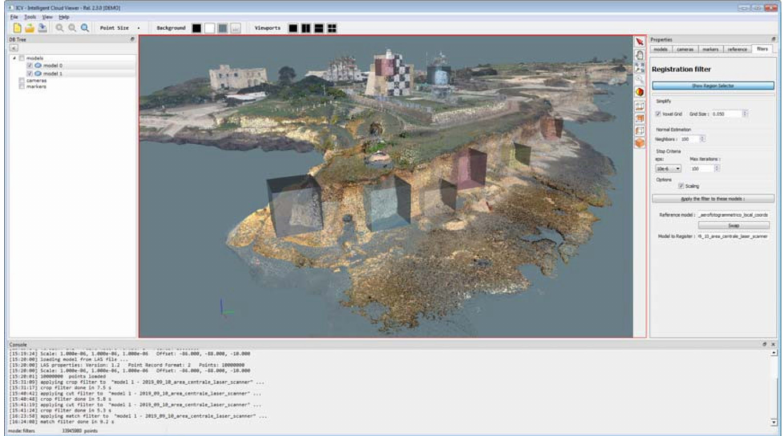
Figure 18. Choice of bounding boxes for end of